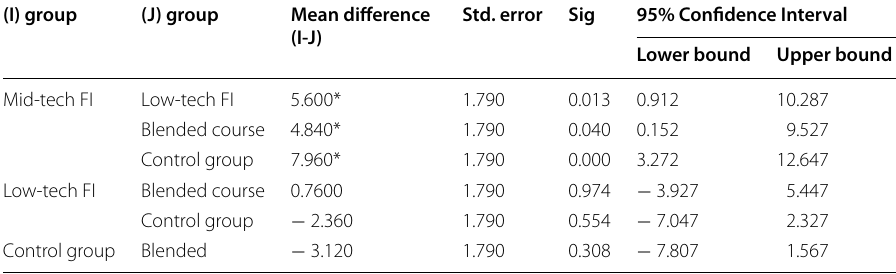
Table 7 Multiple comparisons (Tukey HSD) (I) group (J) group